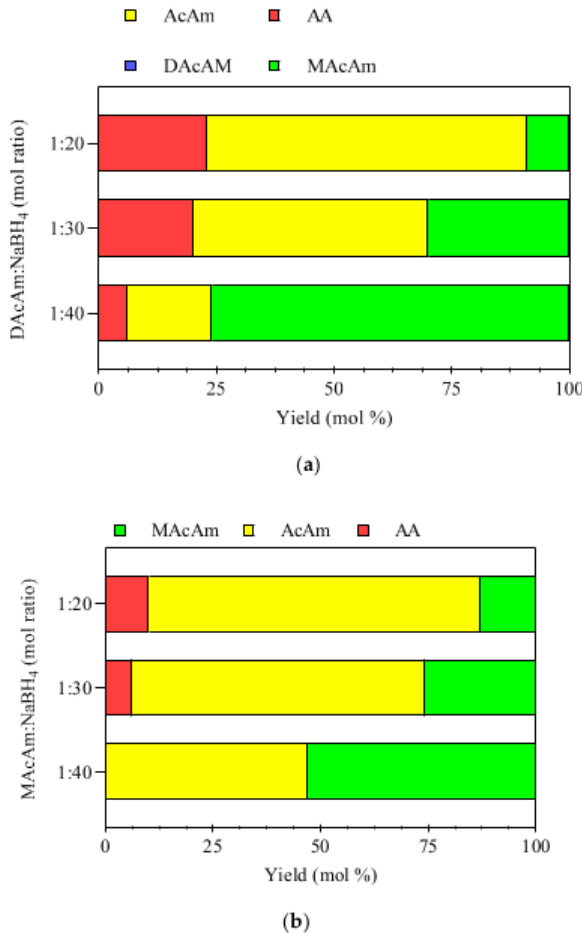
Figure 10. E ff ect of [NaBH 4 ] on the product distribution. The reaction suspensions in water contained 0.10 g catalyst at room temperature. Reaction time 15 min. ( a ) [DAcAm] = 8.8 mM; ( b ) [MAcAm] = 8.8